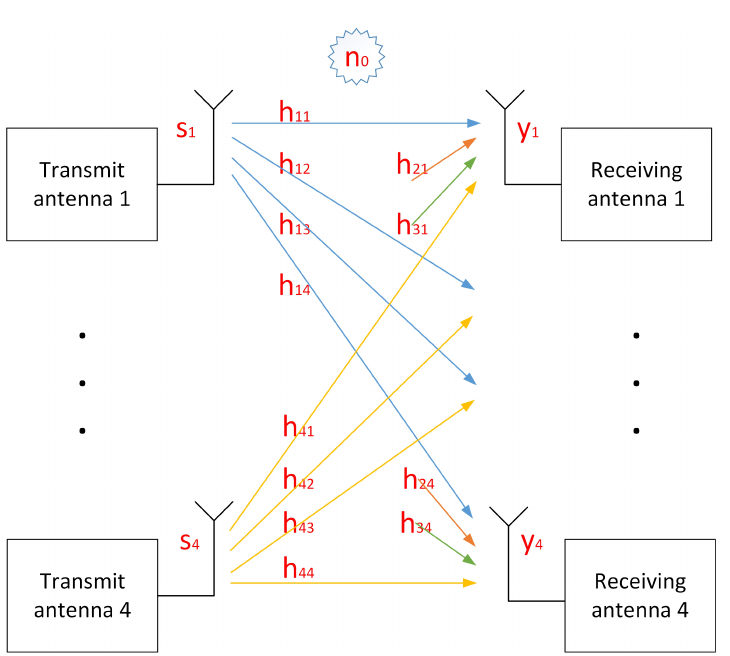
Figure 4. Transmission model of 4 × 4 MIMO system corresponding to Equation